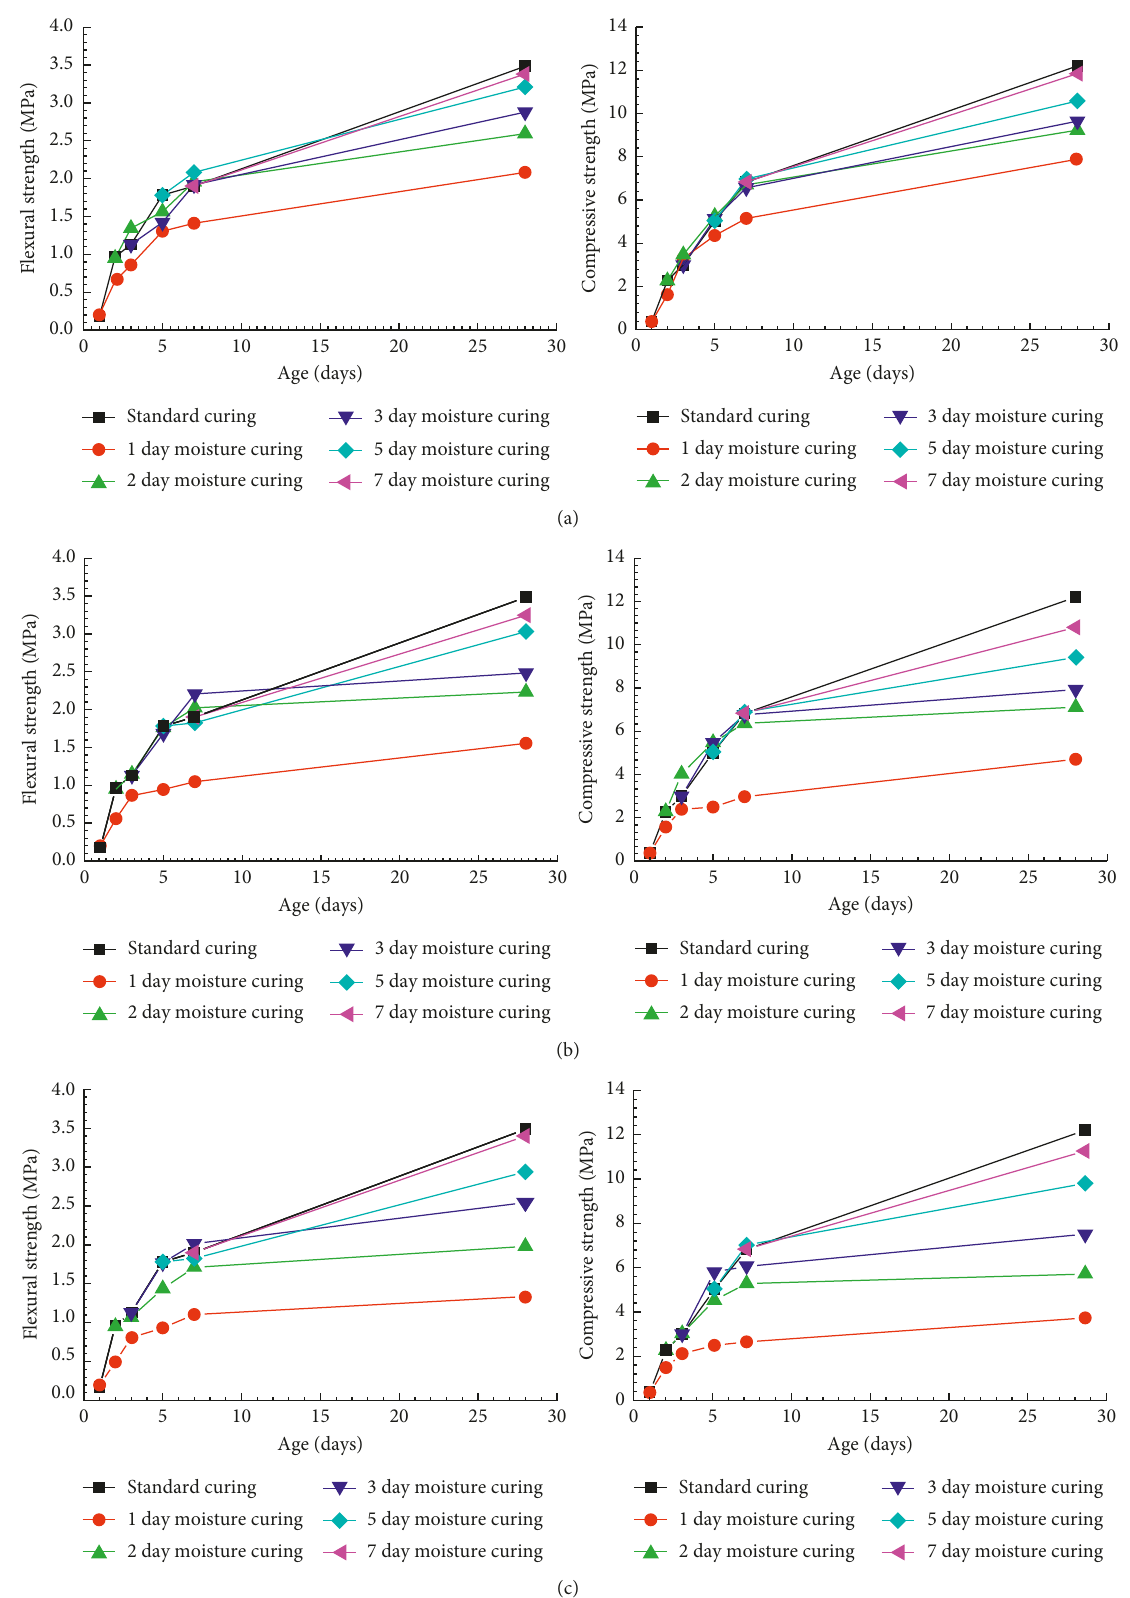
Figure 5: Flexural strength and compressive strength with different wind speeds. (a) 0m/s. (b) 4m/s. (c)